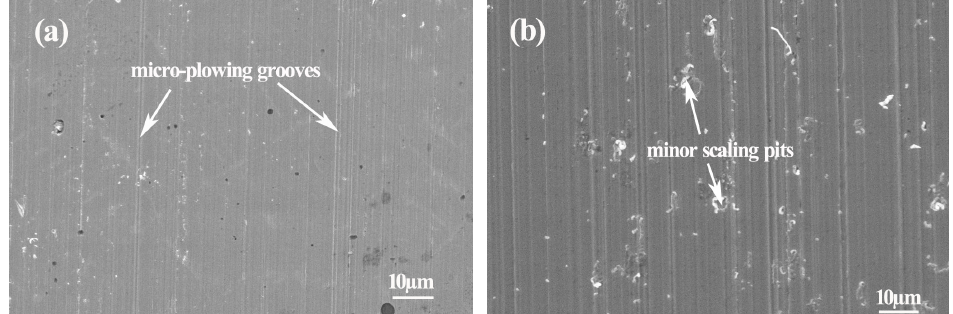
Figure 6. Worn surface morphologies of ( a ) the Ni–Mo–Si ternary intermetallic composite and ( b ) high-chromium cast-iron after abrasive wear for 18 m at room temperature.